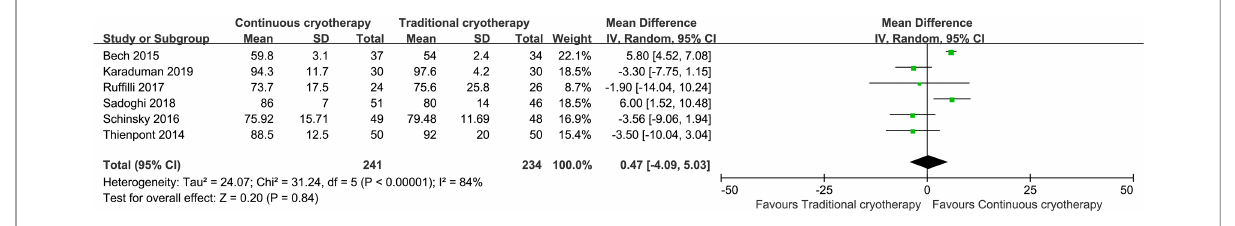
FIGURE 6 Forest plot for postoperative range of motion.